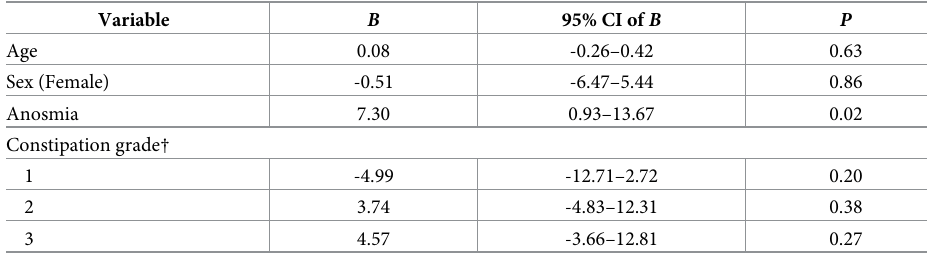
Table 3. Multiple linear regression analysis on MDS-UPDRS part 3 score.